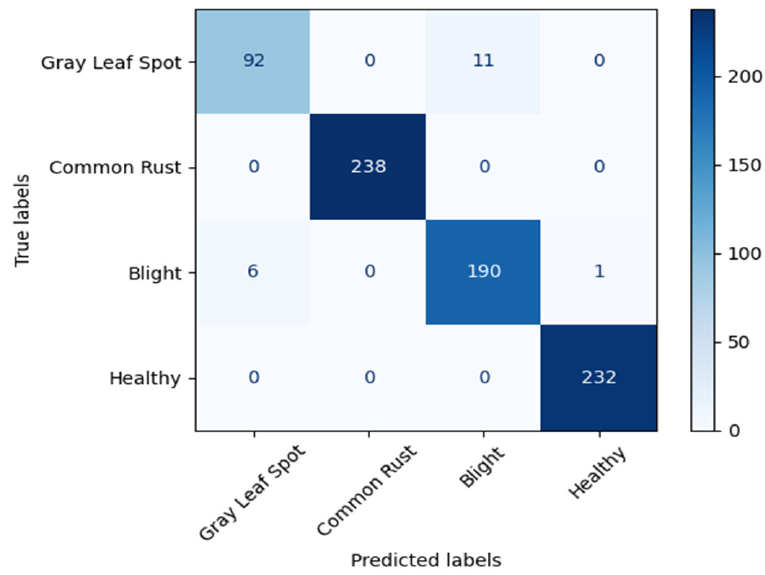
Figure 8. Confusion matrix of the original PCENet.